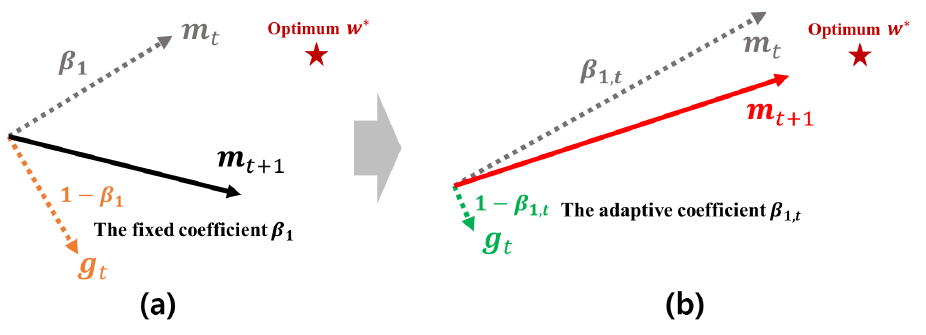
Figure 5. A brief mechanism of the first-momentum computation in HyAdamC. ( a ) describes a comparison of the existing first momentum computation method. ( b ) shows the new first momentum computation methods used in